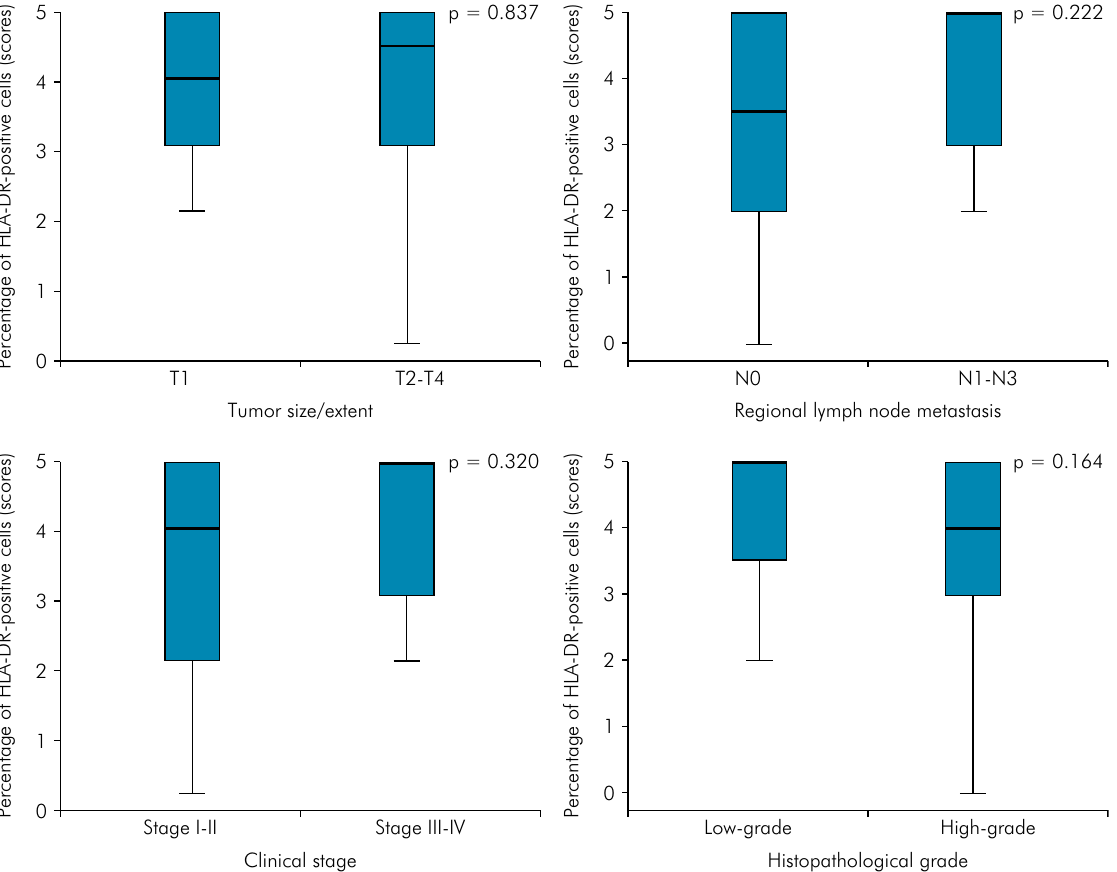
Figure 2. Box plot charts illustrating the scores of HLA-DR-positive cells in LLSCC according to tumor size/extent, regional lymph node metastasis, clinical stage, and histopathological grade of